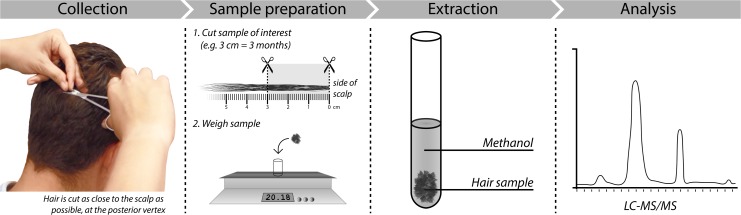
Scalp hair analysis: Hair sample collection, pre-treatment and analysis.LC-MS/MS, liquid chromatography-tandem mass spectrometry. Modified from [21] with permission from the publisher.